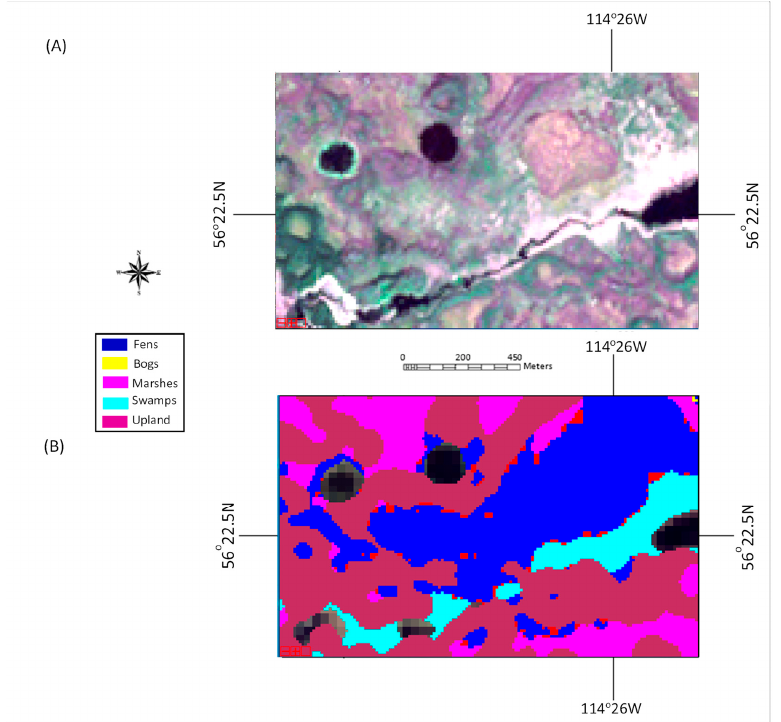
Figure 6. A Test area containing the misclassified pixels with high confidence: ( A ) true-color Sentinel-2 image; ( B ) classification map using the proposed method with the misclassified pixels highlighted in red.